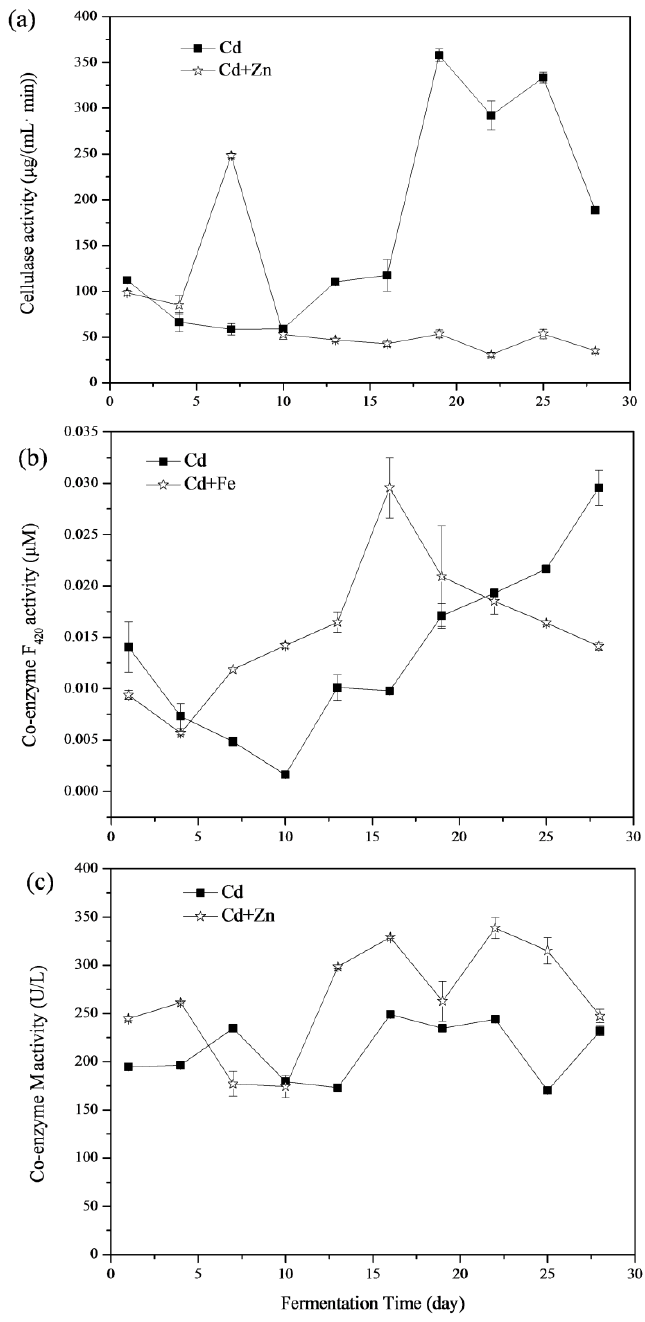
Figure 7. Impact of Cd and Cd+Zn addition on cellulase activity ( a ) coenzyme F 420 activity, ( b ) Figure7. ImpactofCdandCd + Znadditiononcellulaseactivity( a )coenzymeF 420 activity, ( b )coenzyme coenzyme M, and ( c ) activity during the fermentation. M, and ( c ) activity during the